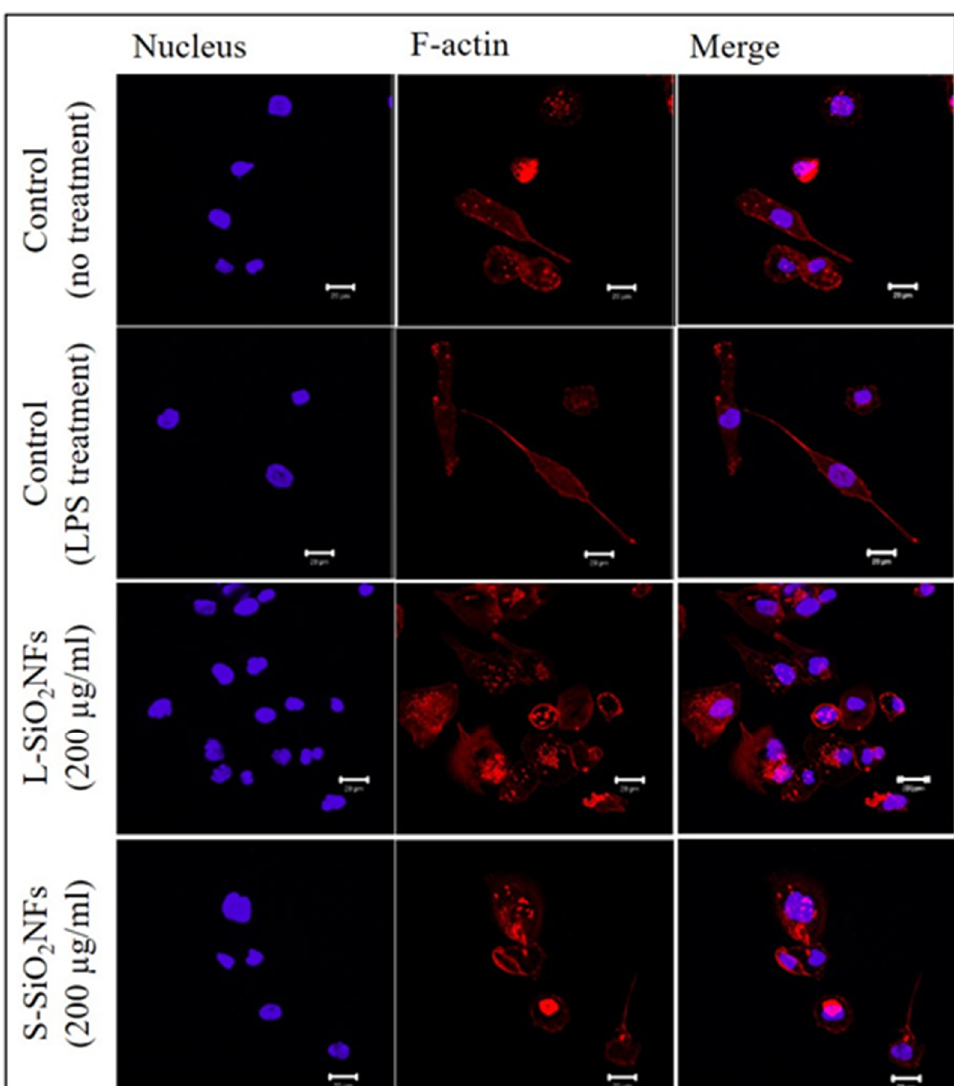
Figure 5. The effect of SiO 2 NF lengths on F-actin expression. THP-1-derived macrophage-like cells were stained with rhodamine-conjugated phalloidin (F-actin—red) and with DAPI (nucleus—blue) after 24 h of treatment with 200 µg/mL SiO 2 NFs. First row: nontreated control cells, second row: control cells treated with LPS, third row: after treatment with L-SiO 2 NFs, and fourth row: after treatment with S-SiO 2 NFs. Scale bar is 20 µm.